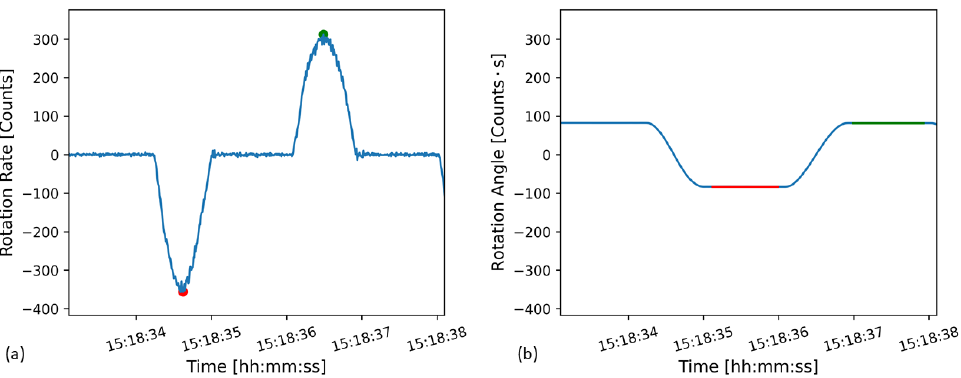
Figure 2. Tilt table output from sensor number 0110 ( a ) direct output showing the sensor being tilted in the negative rotation direction, peak rotation rate in red, and then back, peak rotation rate in green, ( b ) Integrated output showing the rotation